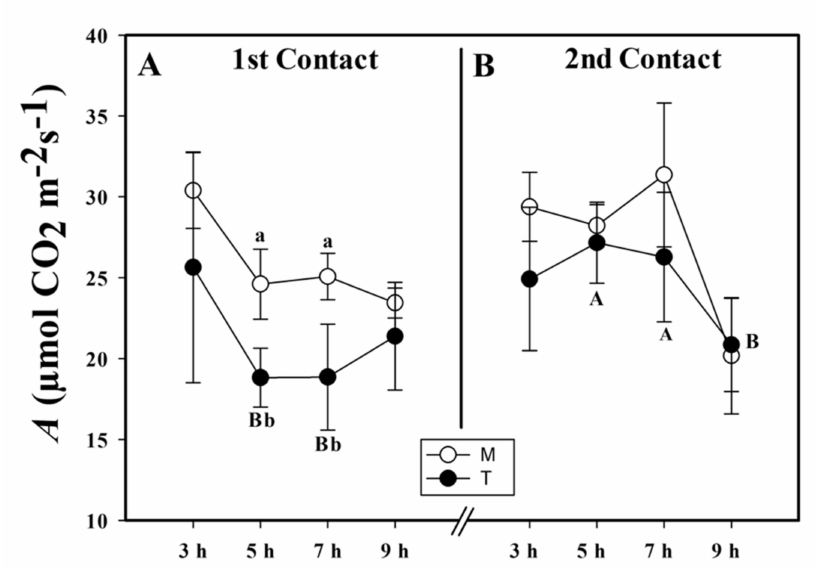
Figure 1. CO 2 net assimilation ( A , µ mol CO 2 m − 2 s − 1 ) of the first ( A ) and second ( B ) contact with the methyl jasmonate (MeJa) (treated (T)) and mock (M) groups. MeJa was applied to the first fully expanded leaf of the plants in the T group at 6:00 a.m., 0 h after application (HAA), and evaluations were made at 3, 5, 7, and 9 HAA. The results are from a one-way ANOVA repeated measures, followed by Tukey’s test with a significance level of 5% ( p < 0.05). The data refer to means ( n = 4), error lines indicate standard deviation. Lowercase letters indicate differences between the T and M groups in the respective contact, while uppercase letters indicate differences between the first and second contact in the T group ( p <